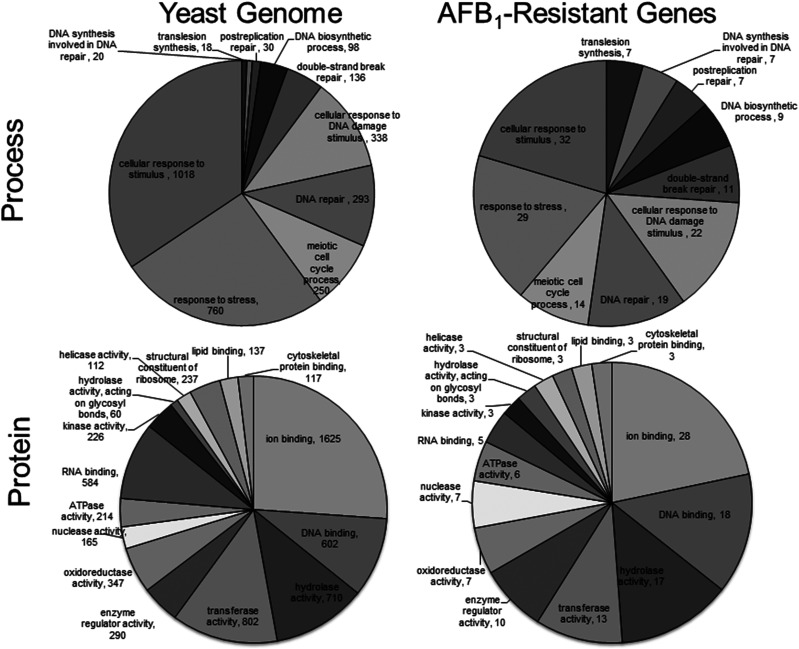
GO enrichment 79 AFB1 resistance genes, according to biological process and protein function. The top circles represent the number of genes of that are grouped according to Process, using the Generic Gene Ontology Term Finder, http://go.princeton.edu/cgibin/GOTermFinder. The bottom circles are those which are grouped according to protein function, using GO term finder according to function, https://www.yeastgenome.org/goSlimMapper. GO process groups included translesion synthesis, DNA synthesis involved in DNA repair, postreplication repair, DNA biosynthetic process, cellular response to DNA damage, DNA repair, meiotic cell cycle process, response to stress, and cellular response to stimulus. GO function groups include ion binding, hydrolase, nucleic acid binding, oxidoreductase, and transcription factors. Number of genes belonging to each GO is indicated within or just outside the pie slice.